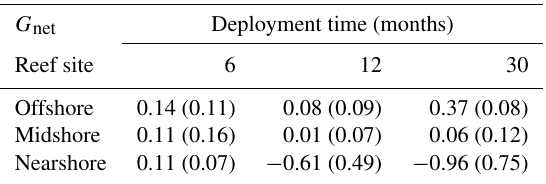
Table 2. Net-accretion/-erosion rates G net (kg CaCO 3 m − 2 yr − 1 ) in coral reefs along a cross-shelf gradient in the central Red Sea. G net was calculated using weight gain/loss of limestone blocks that were deployed in the reefs. For each deployment duration, 6, 12, and 30 months, a set of four replicate blocks was used. Each block was measured once. Provided are means per reef site and standard deviations (in